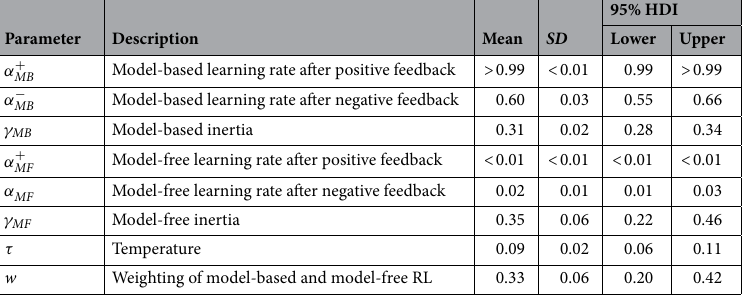
Table 4. Summary statistics of group-level parameter estimates of the wP-RL model. Posterior distributions of Probit-transformed group-level location parameters from hierarchical Bayesian analysis are reported. RL reinforcement learning, SD standard deviation, 95% HDI 95% highest density